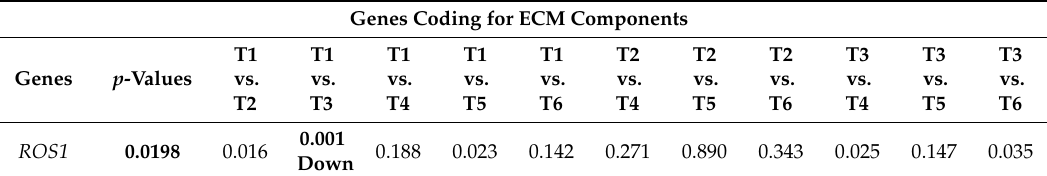
Table 6. Di ff erentially expressed genes coding for ECM components.